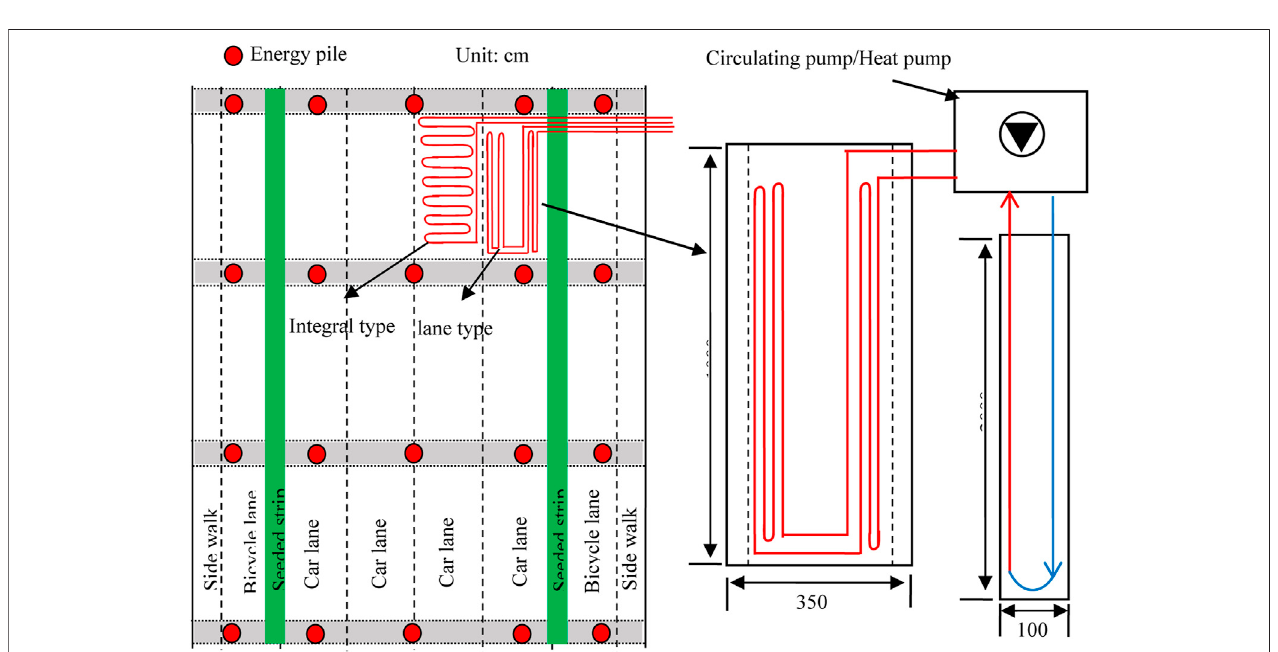
FIGURE 9 | Basic information of the bridge for energy pile-based bridge deck deicing system.